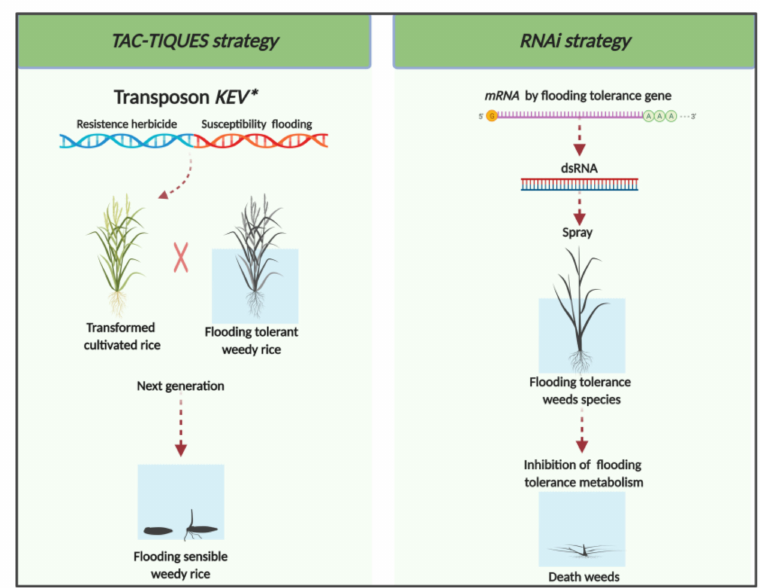
Figure 2. Scheme illustrating the potential application of biotechnological approaches for managing flood-tolerant weeds. UFRGS, June